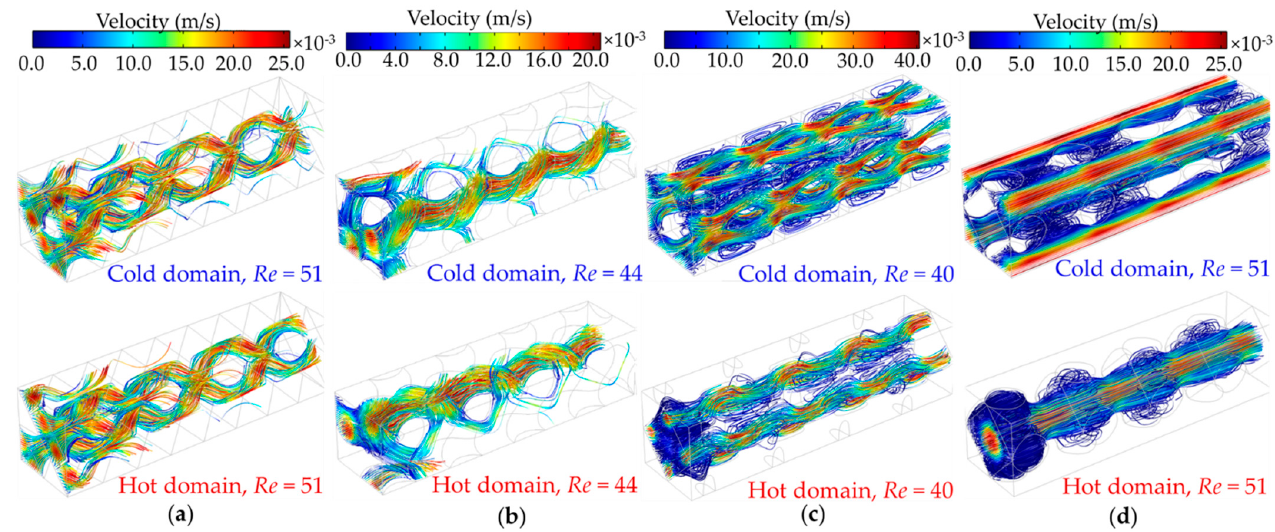
Figure 15. Velocity streamlines in the cold and hot fluid domains at Re = 40 – 51. (More flow characteristics of other TPMS structures are provided in Ref. [55]): ( a ) Sheet-Diamond; ( b ) Sheet-Gyroid; ( c ) Sheet-Neovius; ( d ) Sheet-Primitive structures.